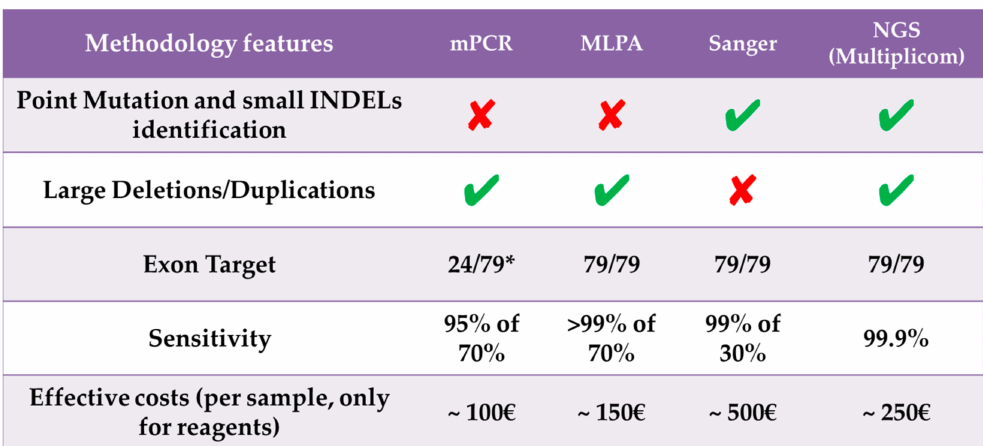
for CNV analysis, Figure S2: Panel of samples with undetermined regions, Figure S3: NGS-based deletion detection in DMD by Sophia Genetics Software, Figure S4: NGS-based duplication detection in DMD by Sophia Genetics Software, Figure S5: Panel of wild-type samples for CNV